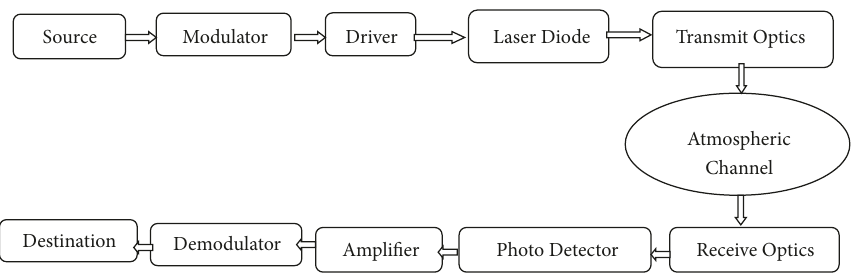
Figure 1: Schematic diagram of free space